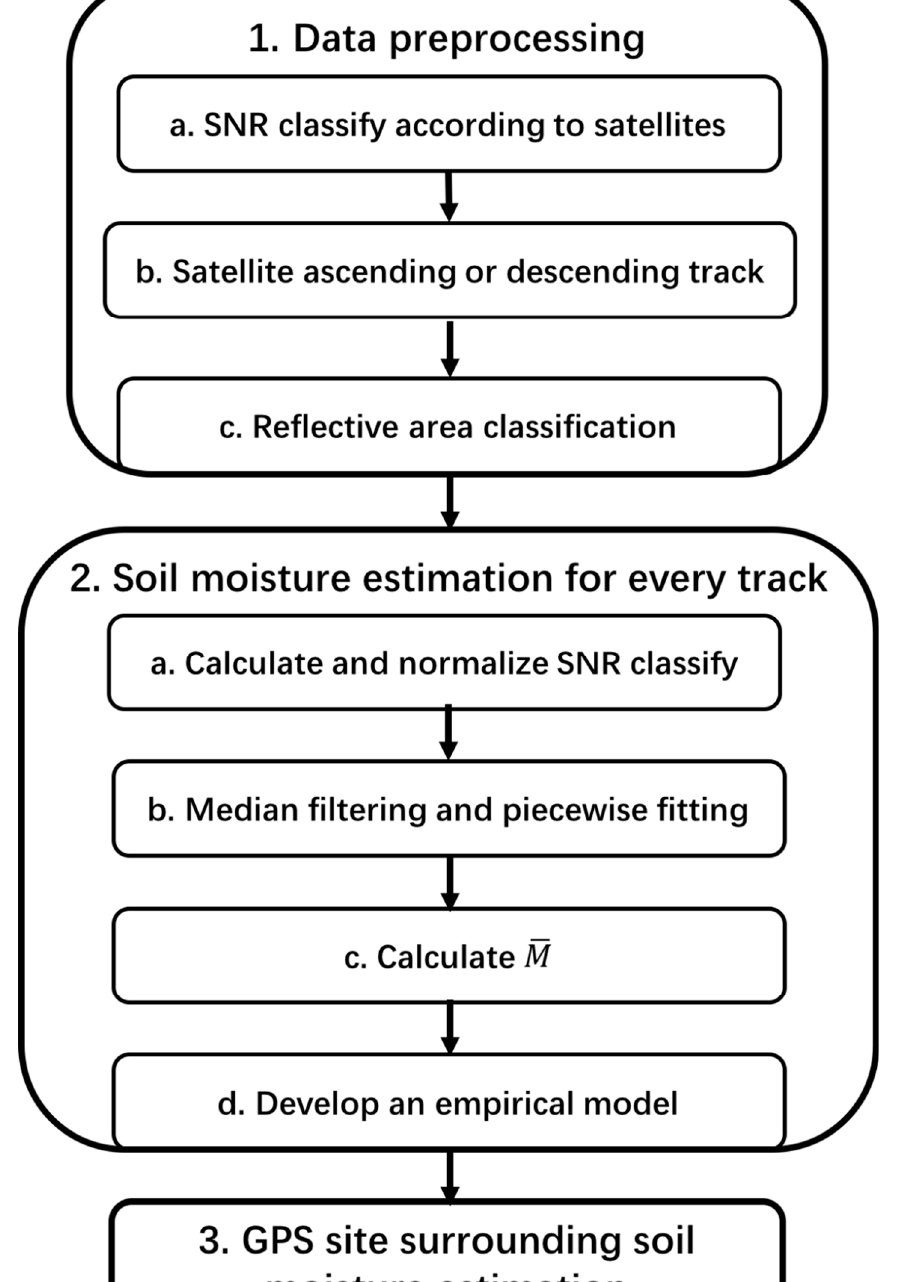
Figure 3. Data processing and soil moisture estimation flow chart.